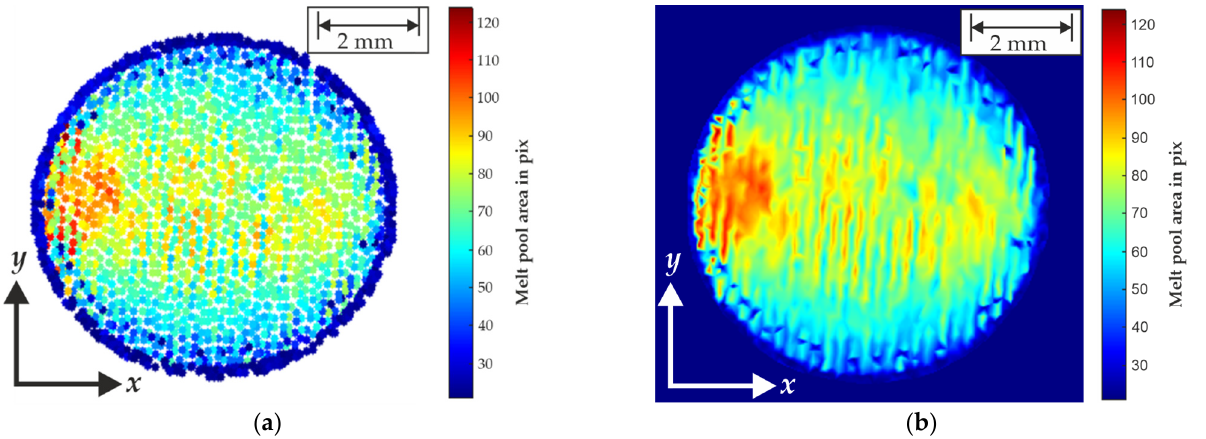
Figure 3. Preprocessing of thermogram feature data (here: melt pool blob size) of layer 59. ( a ) Incremental data points of melt pool blob size containing image distortion. ( b ) Rectified and resampled thermogram with an adjusted scale of 10 μ m/pix.